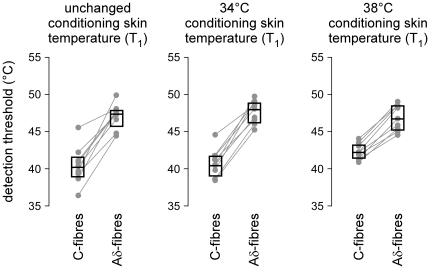
Thermal detection threshold of the behavioural responses triggered by Aδ- and C-fibre input obtained in the three experimental conditions (T1 = unchanged, T1 = 34°C and T1 = 38°C).The thin grey lines represent the individual thresholds obtained in each participant. The box plots represent the group-level median and interquartile range. Note that in all participants, the Aδ-fibre threshold is markedly greater than the C-fibre threshold. Also note that this difference is less marked in the condition T1 = 38°C.